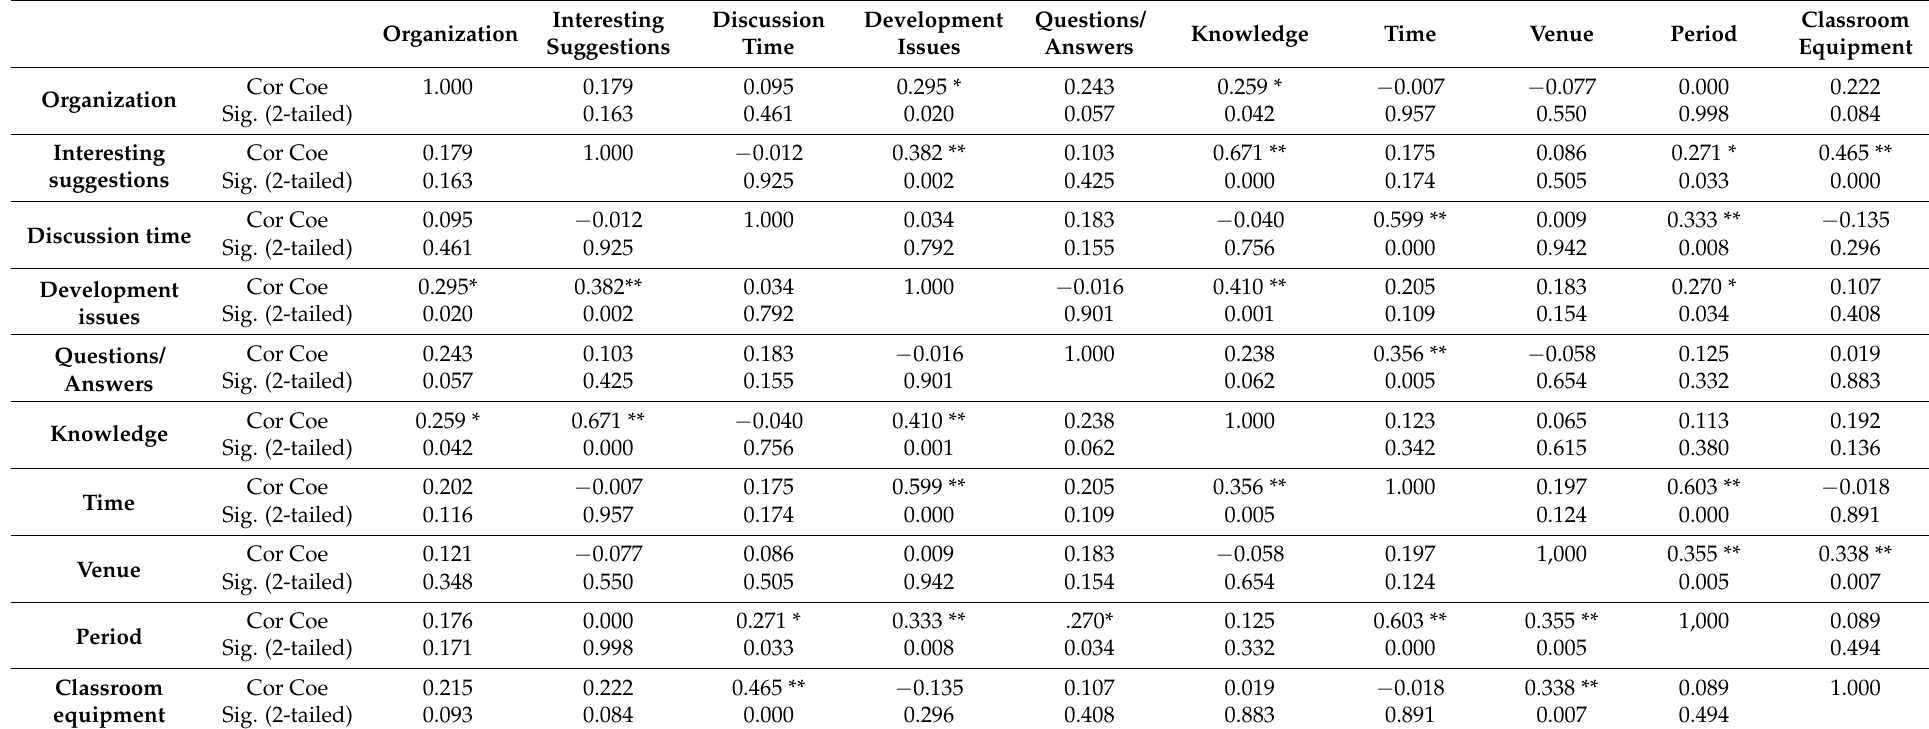
Table 11. Spearman’s rho correlation test for parameters of educational